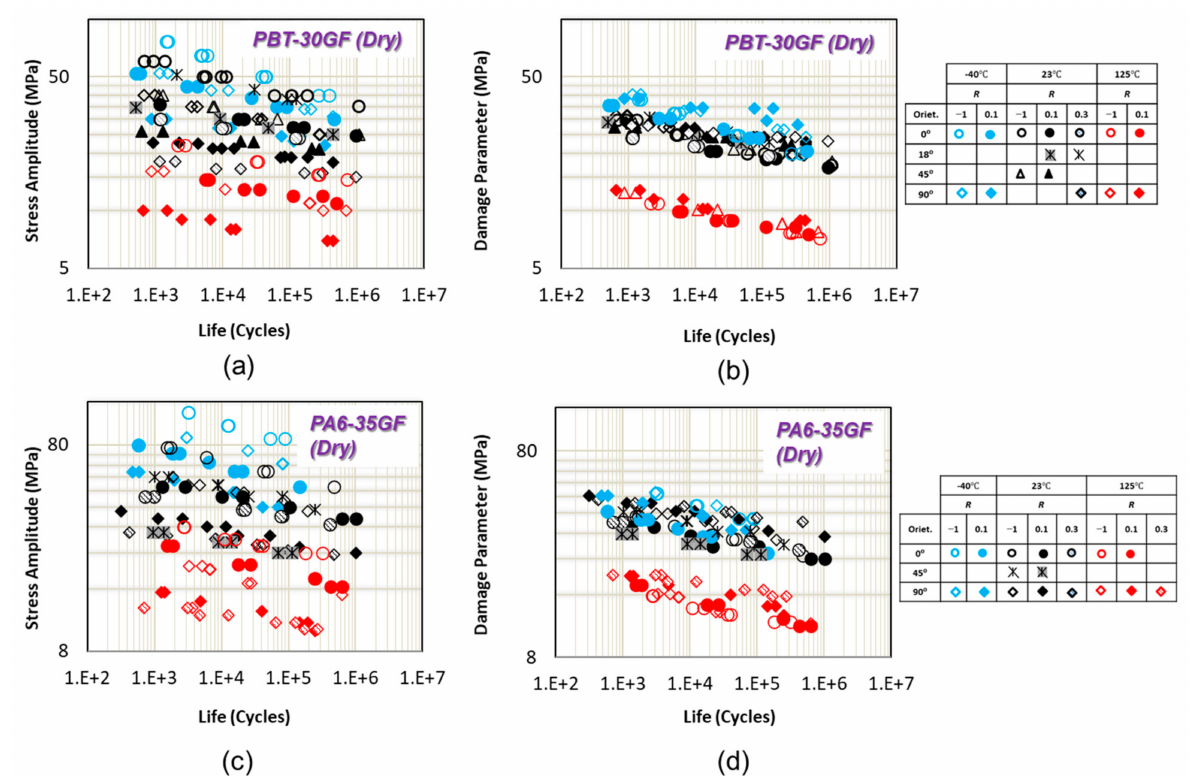
Figure 5. ( a ) Uniaxial fatigue data of PBT-30GF from [6]. ( b ) Uniaxial fatigue data of PA6-35GF from [6]. ( c ) Uniaxial fatigue data correlations of PBT-30GF using the proposed damage parameter. ( d ) Uniaxial fatigue data correlations of PA6-35GF using the proposed damage